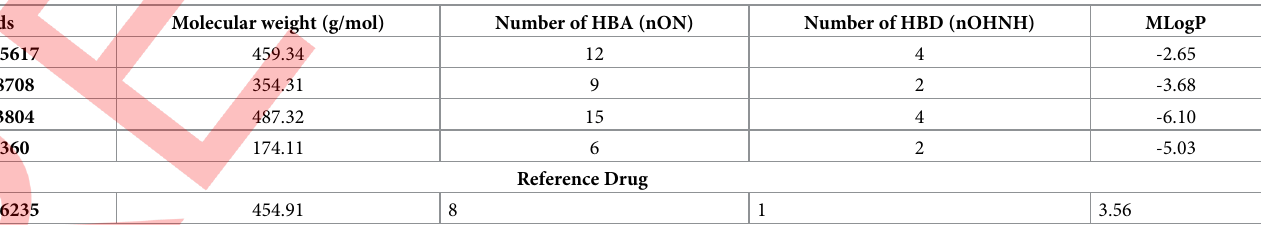
Table 2. Drug candidates exhibiting Lipinski rule of five.